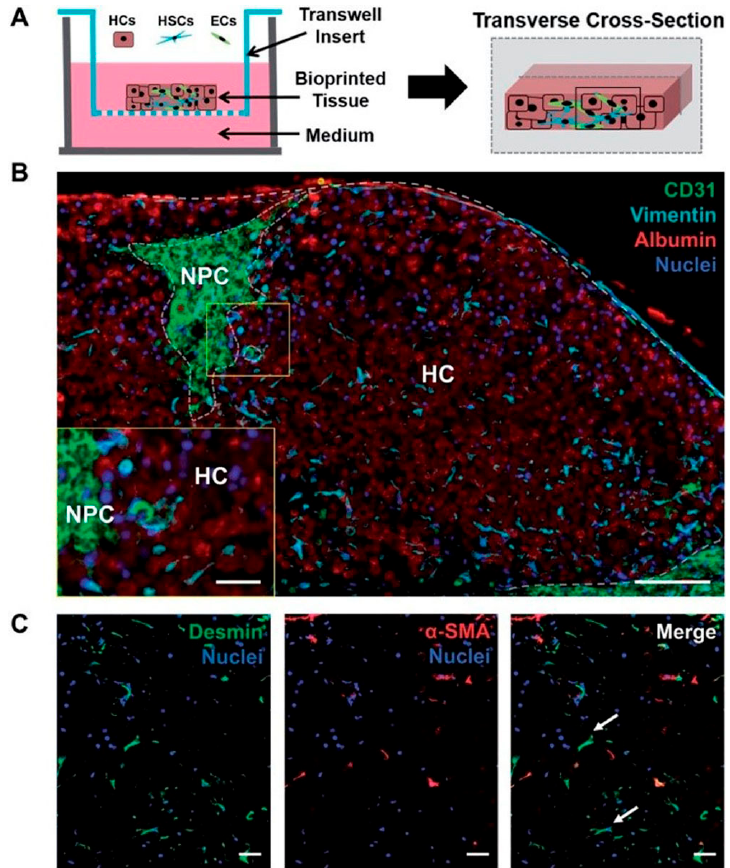
Figure 9. 3D bioprinted tissue exhibits a compartmentalized architecture and maintains hepatic stellate cells in a quiescent-like phenotype. ( A ) Illustration of a transverse cross-section of bioprinted tissue on a transwell insert comprising hepatocytes (HCs) and compartmentalized endothelial cells (ECs) and hepatic stellate cells (HSCs). ( B ) The organization of non-parenchymal cells (NPCs) is depicted with CD31 and vimentin staining to mark ECs and HSCs, respectively. Albumin is used to denote the hepatocellular compartment (HC). Scale bar = 100 µ m, inset scale bar = 25 µ m. ( C ) HSC activation status was examined using desmin (generic marker) and Alpha-smooth muscle actin ( α -SMA) (activation marker). Quiescent HSCs are denoted with white arrows. Scale bar = 50 µ m [95].